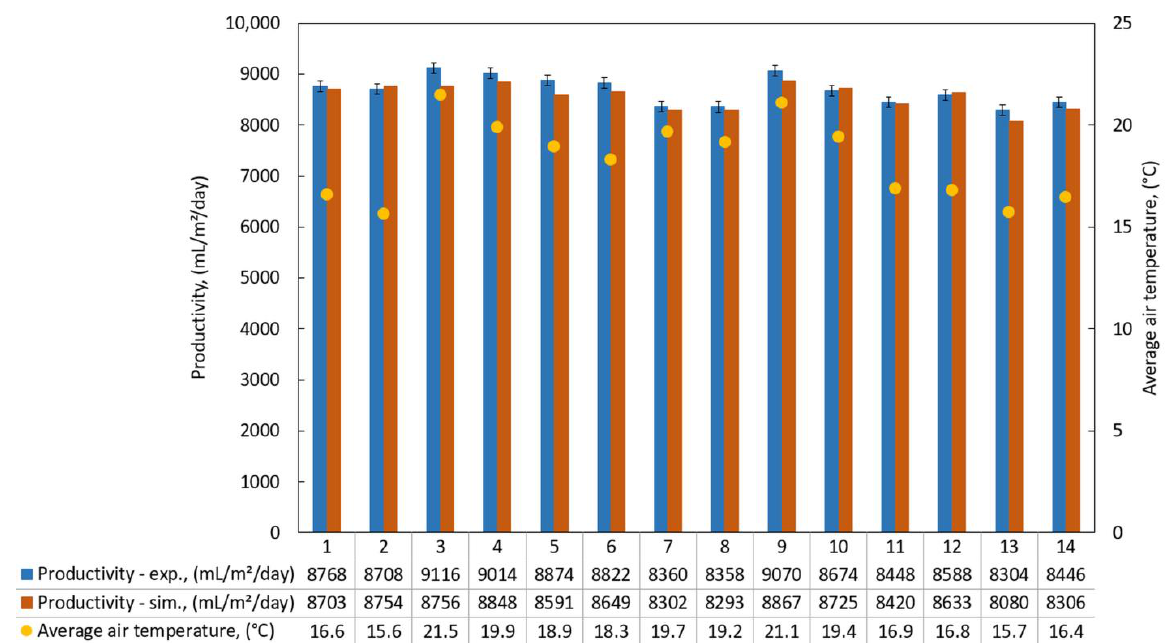
Figure 9. The daily productivity of the SS from experiments (exp.) and simulations (sim.) and the average air temperature. (The numbers 1 through 14 indicate the experimental conditions as given in Table 2).